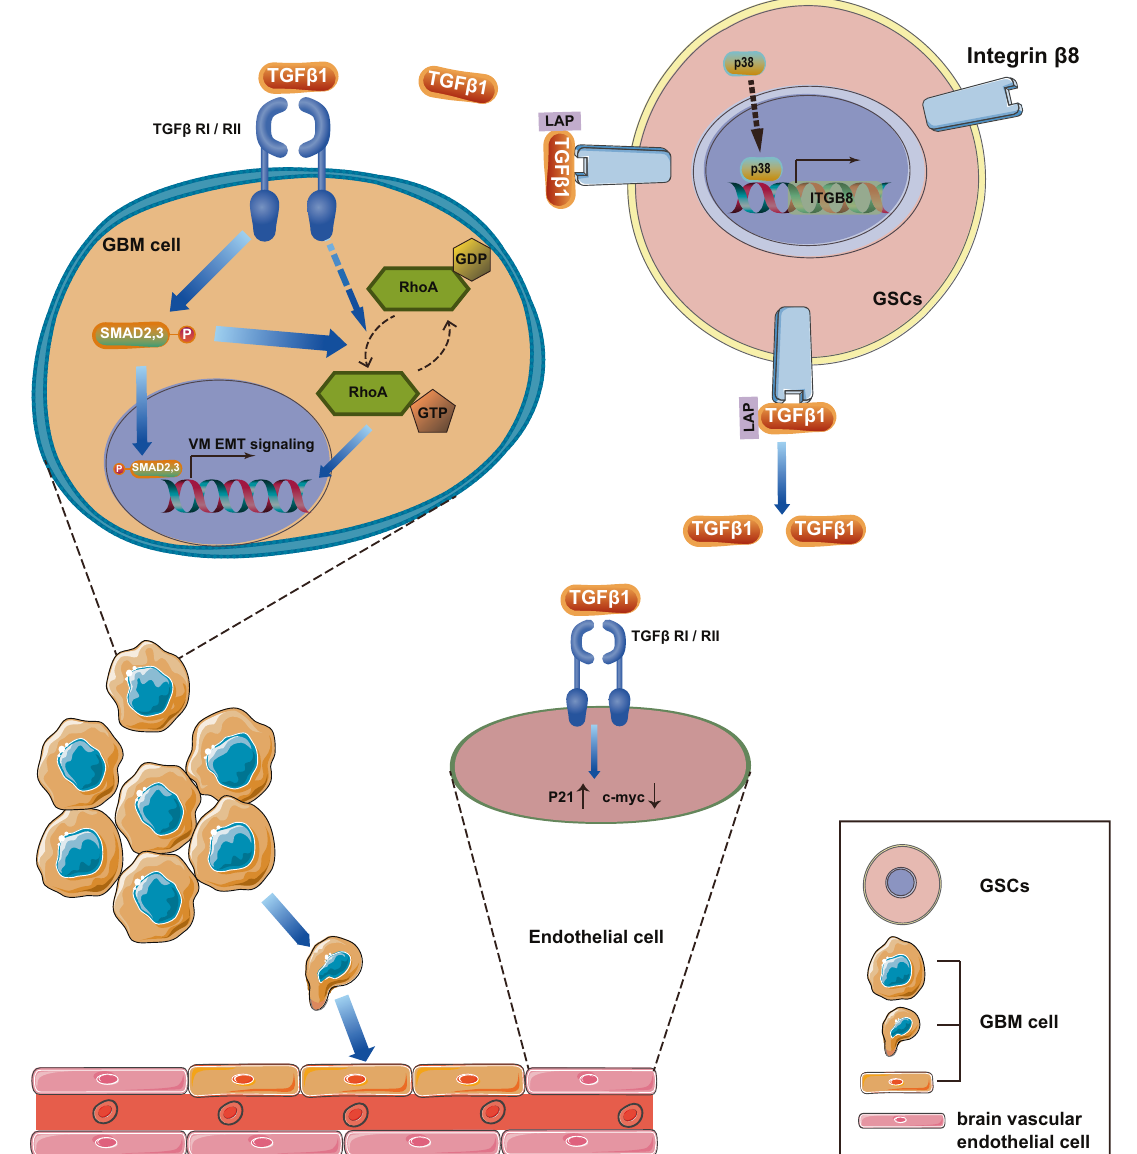
Fig. 7 Schematic diagram illustrating the β 8 integrin-TGF β 1 axis in VM regulation. GSCs-derived β 8 integrin, which was regulated by p38 activation, released secreted TGF β 1 into GBM microenvironment. GBM cells exhibit activated p-Smad and RhoA and eventually induce VM and EMT phenotype. While human brain microvascular endothelial cells presented upregulated p21 and decreased c-myc expression that ultimately culminate in the suppression of GBM